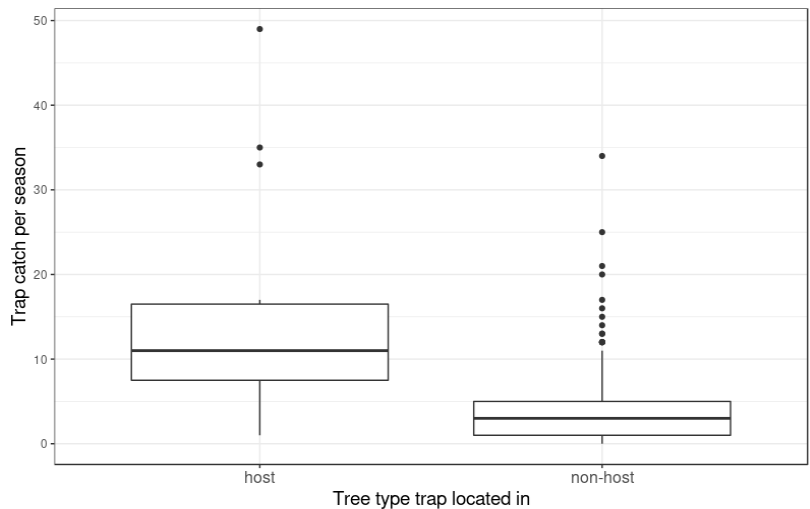
Figure 4. Number of codling moths ( Cydia pomonella ) caught per trap per week when traps were positioned in host ( n = 15) and non-host trees ( n = 185). The ends of the boxes are the upper and lower quartiles and the bold line shows the median. The whiskers extend up to 1.5 times the interquartile range from the top of the box to the furthest datum within that distance. If there are any data beyond that distance, they are represented individually as points ('outliers').